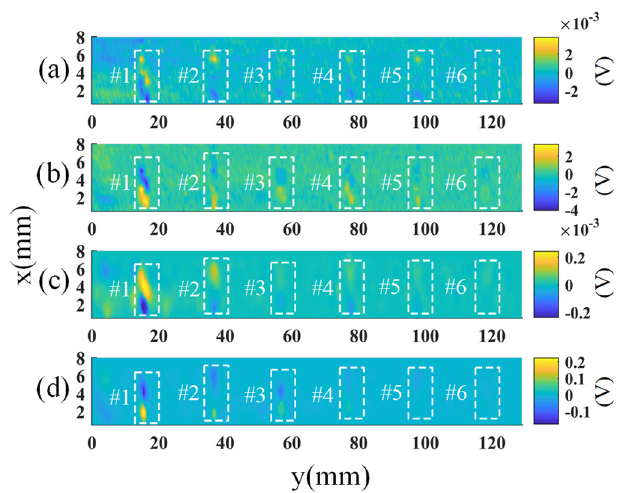
Figure 12. ( a , b ) are the original images of the SD and OD mode, respectively, and ( c , d ) are the corresponding processed images.